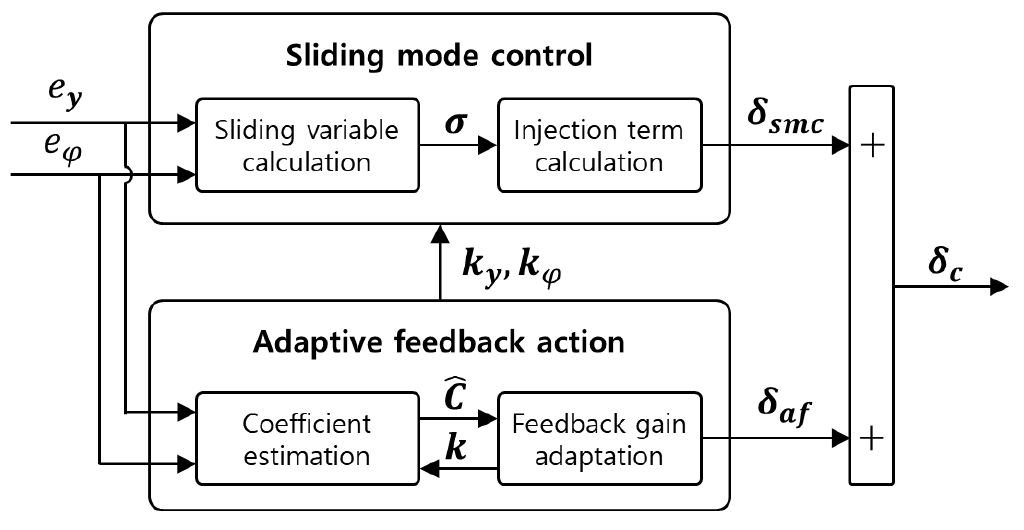
Figure 2. Block diagram for the adaptive feedback action-based sliding mode